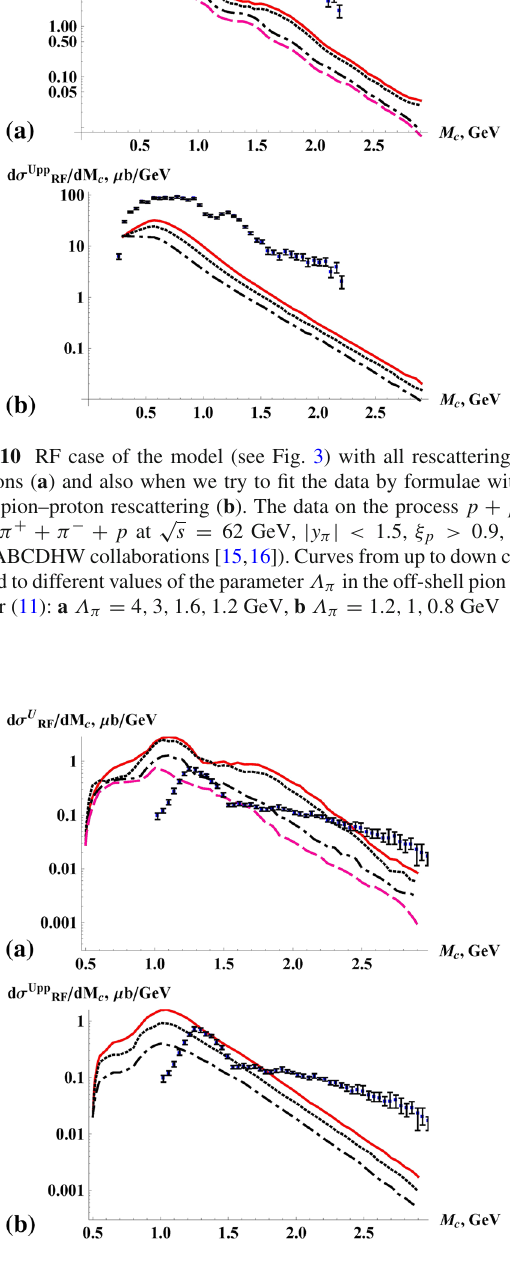
Fig. 11 RF case of the model (see Fig. 3) with all rescattering cor- rections ( a ) and also when we try to fit the data by formulas without final pion–proton rescattering ( b ). The data on the process p + ¯ p → √ p + π + + π − + ¯ p at s = 1 . 96 TeV, | η π | < 1 . 3, | y ππ | < 1, p T ,π > 0 . 4GeV,(CDFcollaboration[19,20]).Curvesfromuptodown correspond to different values of the parameter Λ π in the off-shell pion Fig. 14 RF case of the model (see Fig. 3) for the CMS energy. Curves form factor (11): a Λ π = 4 , 3 , 1 . 6 , 1 . 2 GeV, b Λ π = 1 . 2 , 1 , 0 . 8 GeV from up to down correspond to the Born term, the amplitude with proton–proton rescattering corrections only and the one with all the corrections (proton–proton and pion–proton). Λ π = 3